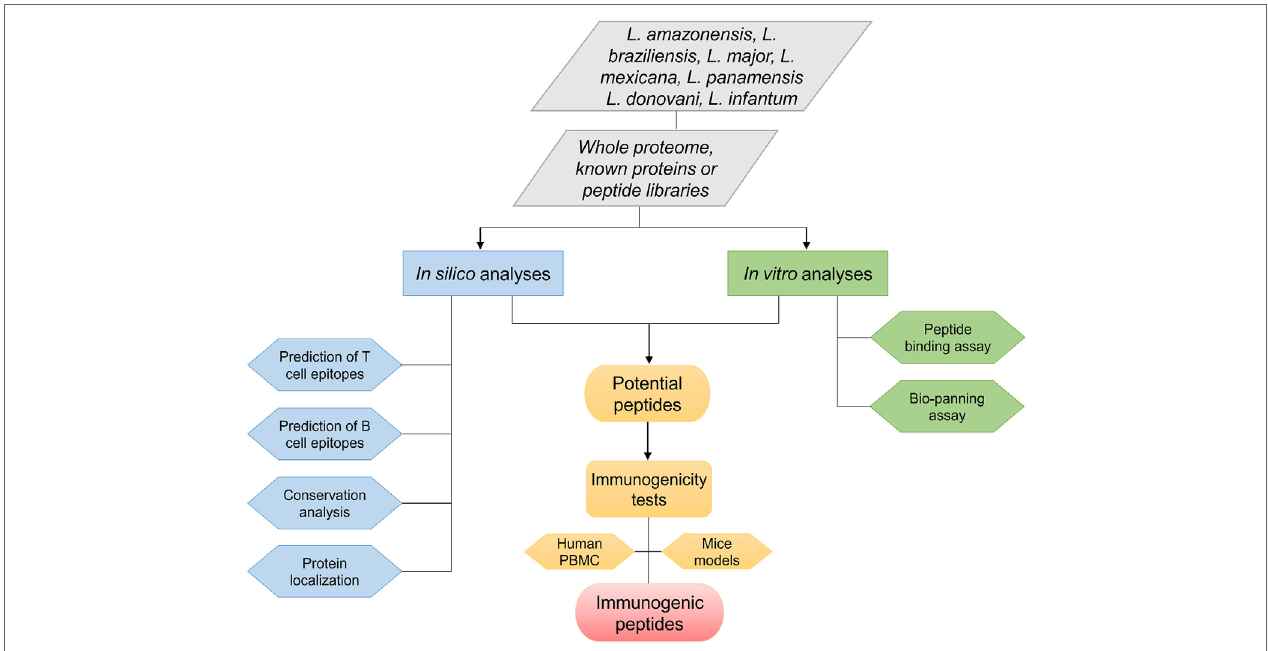
FigURe 1 | Flowchart of various approaches used to identify promising immunogenic peptides of different Leishmania